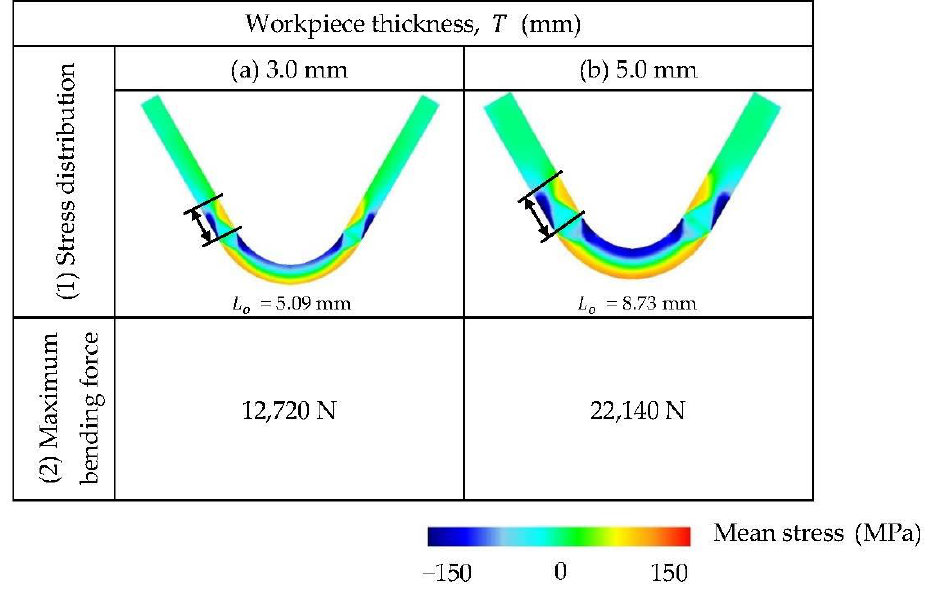
Figure 11. Illustration of mean stress and bending force with respect to workpiece thickness ( 𝑅 𝑝 = 9.0 mm, 𝜃 = 60°, AA1100-O, 𝐿 = 70 mm, l k = 60 mm).